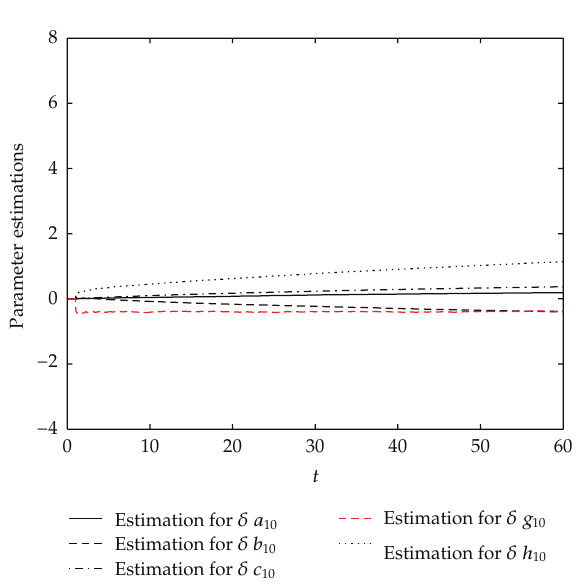
Figure 7: Curves of parameter estimations for the slave